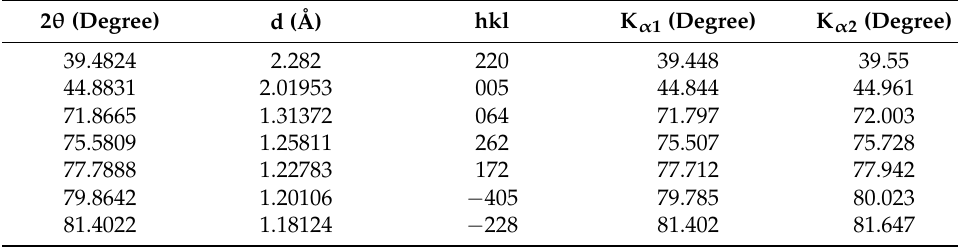
Table A2. K a1 and K a2 peaks for the reflections of the starting material.